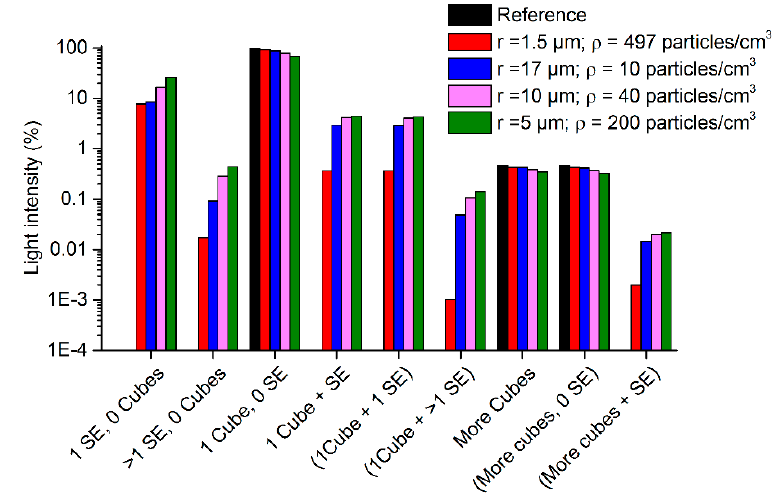
Figure 3. Histogram comparing the contribution of different optical paths to the total light intensity at the sensor for different scattering distributions, ordered with increasing scattering cross section. SE = Scattering